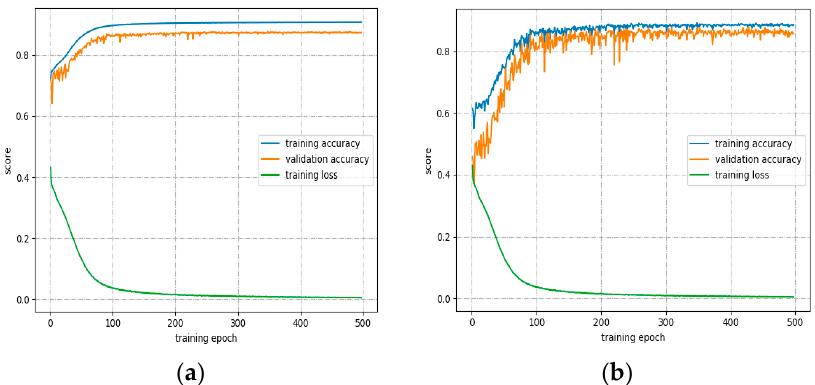
Figure 7. Training logs for the A-LSTM model, ( a ) model trained on a mixed dataset, ( b ) model trained on a pure dataset.